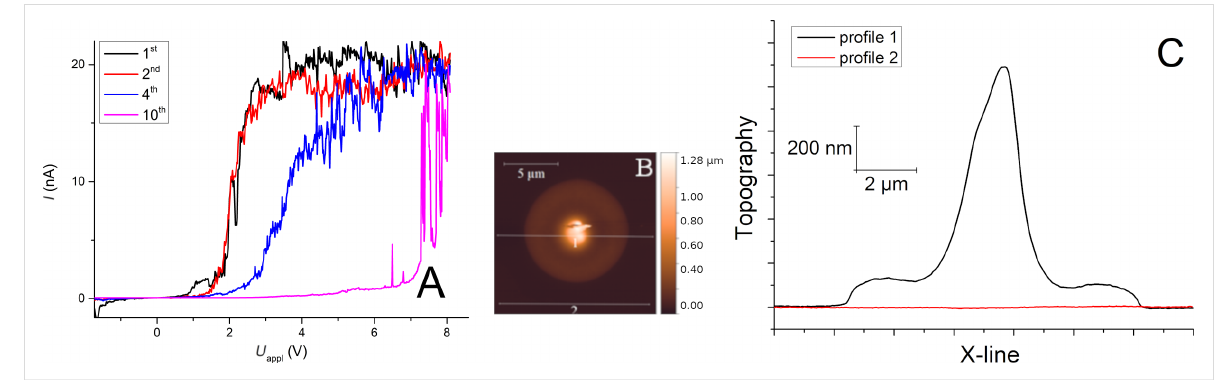
Figure 4: (A) Change of the I – V characteristics for ten repetitions of a single-point and (B) induced changes in the topography and (C) height profiles across a perturbation and a non-affected area (horizontal lines in (B)).